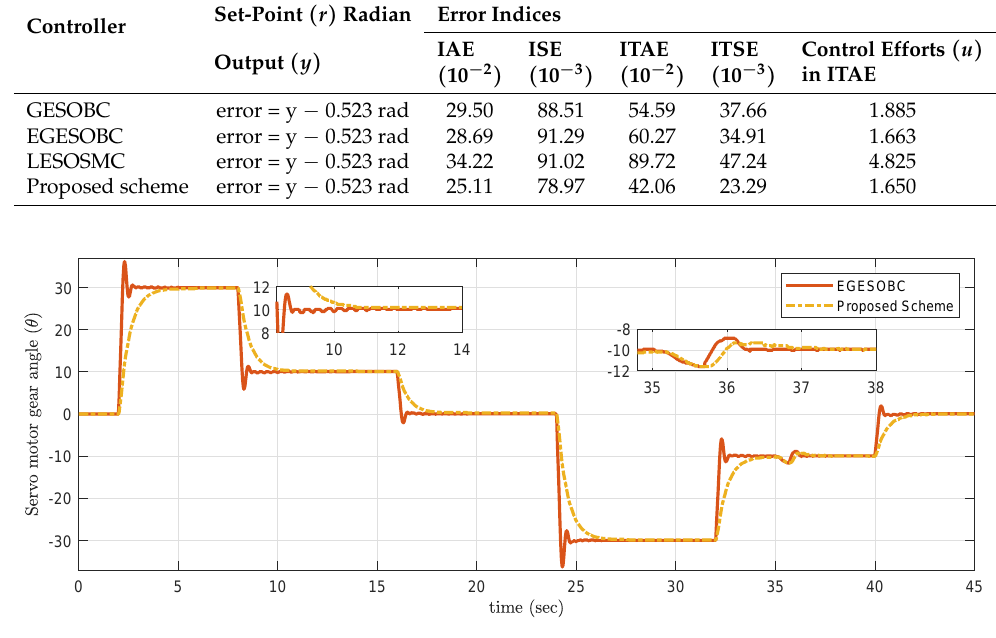
Figure 15. Experimental result of output tracking θ